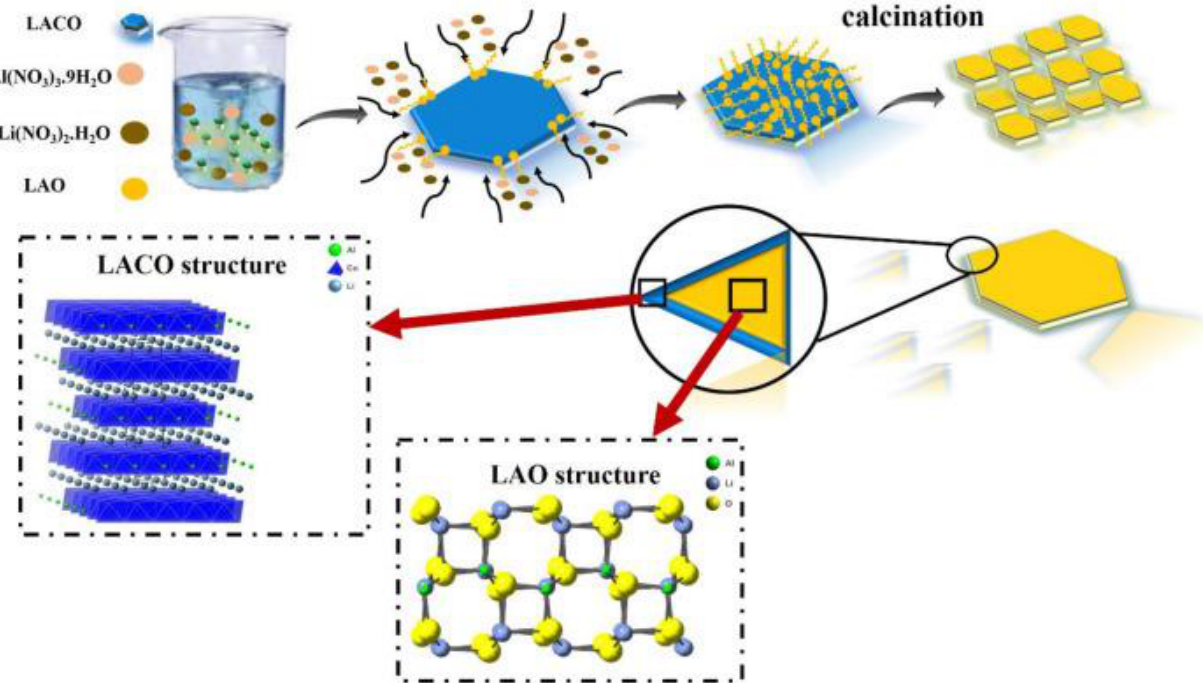
Figure 5. Schematic showing the surface coating process of LAO on LACO. Reprinted with permission from [64]. Copyright 2021 Elsevier.